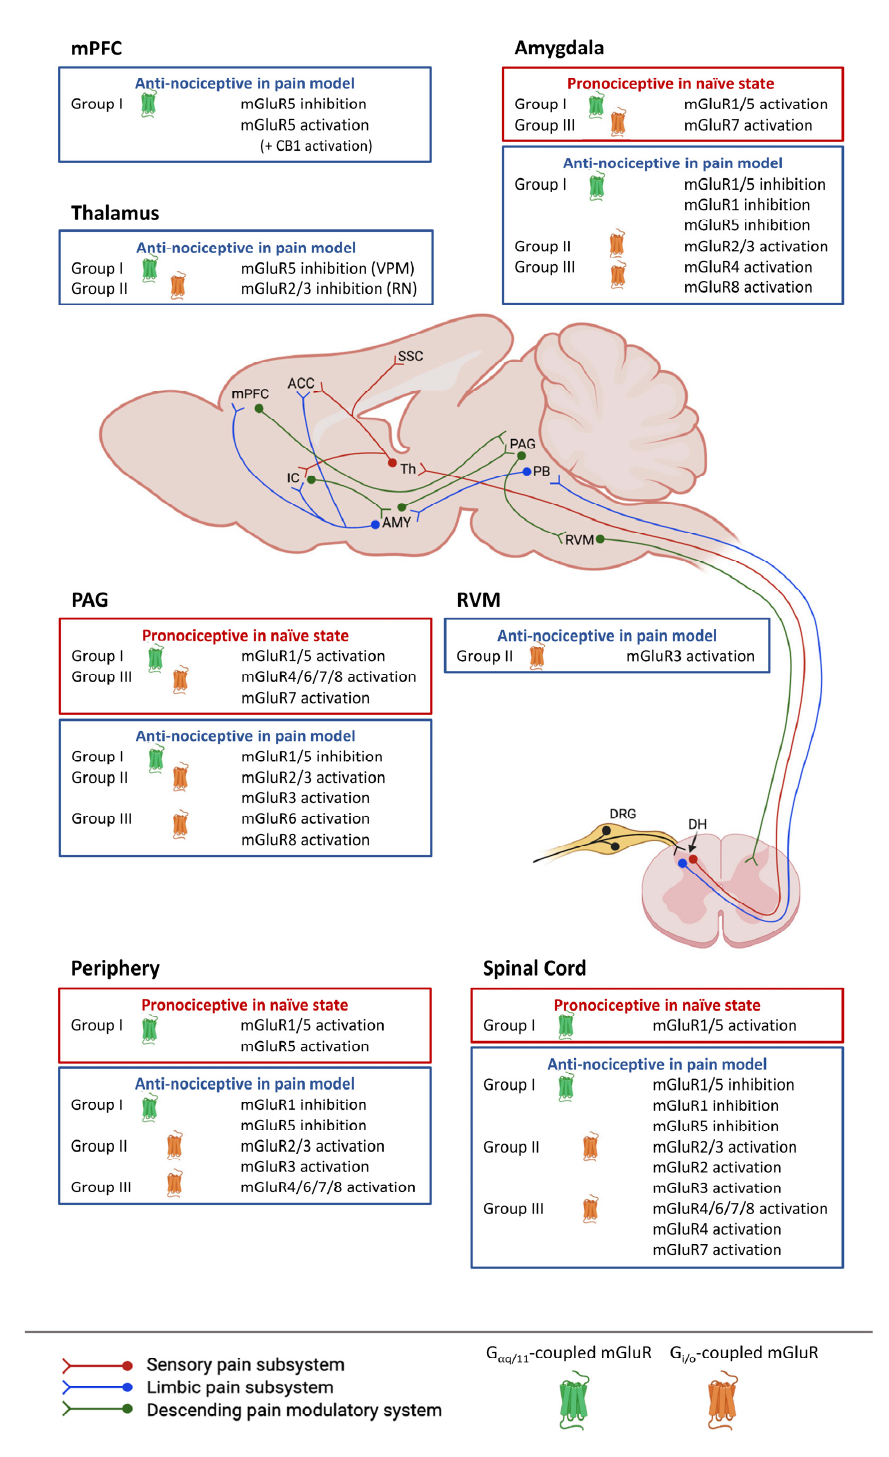
Figure 1. mGluR signaling within the pain system. Nociceptive information is carried from the periphery into the CNS via first-order neurons in the dorsal root ganglia (DRG). Axons from second-order neurons